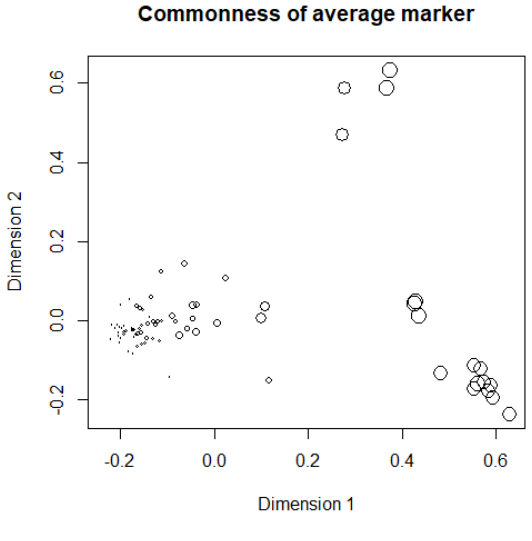
Figure 5. Commonness of average marker. Table 6. Poles of Dimensions 1 and 2 from the principal